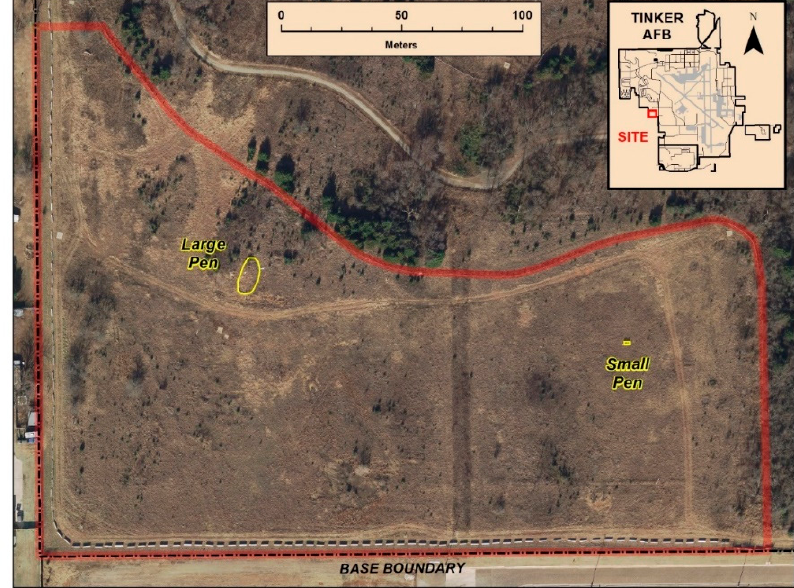
Figure 1. Translocation site on Tinker Air Force Base, Oklahoma. Two soft-release translocation pens were constructed in this 4 ha grassland.